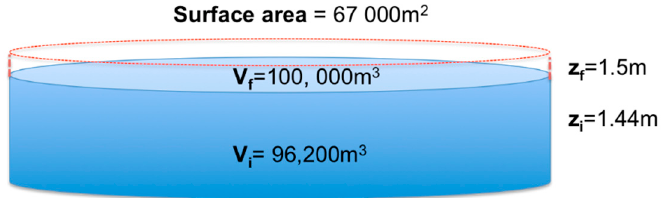
Figure 3. Approximated geometry of the Pond Inlet WSP for ease of calculations.